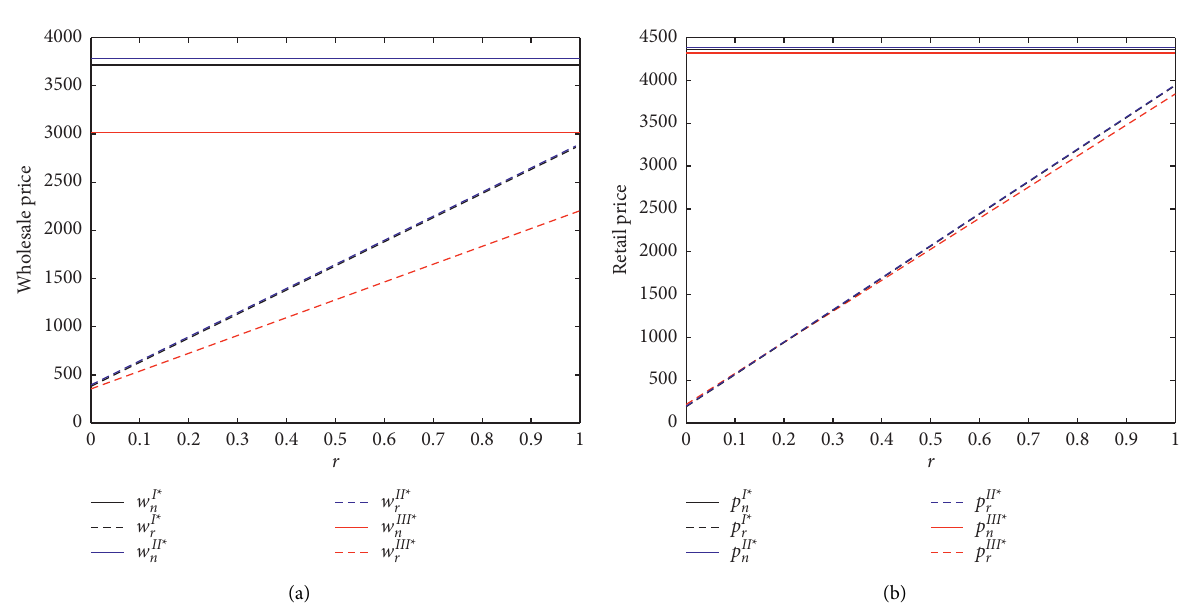
Figure 2: The effects of r on prices. (a) Wholesale prices. (b) Retail